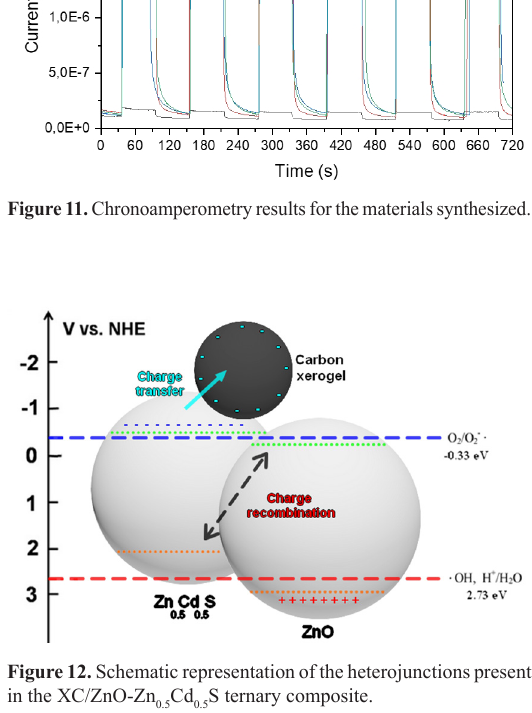
Cd S ternary 0.5 0.5